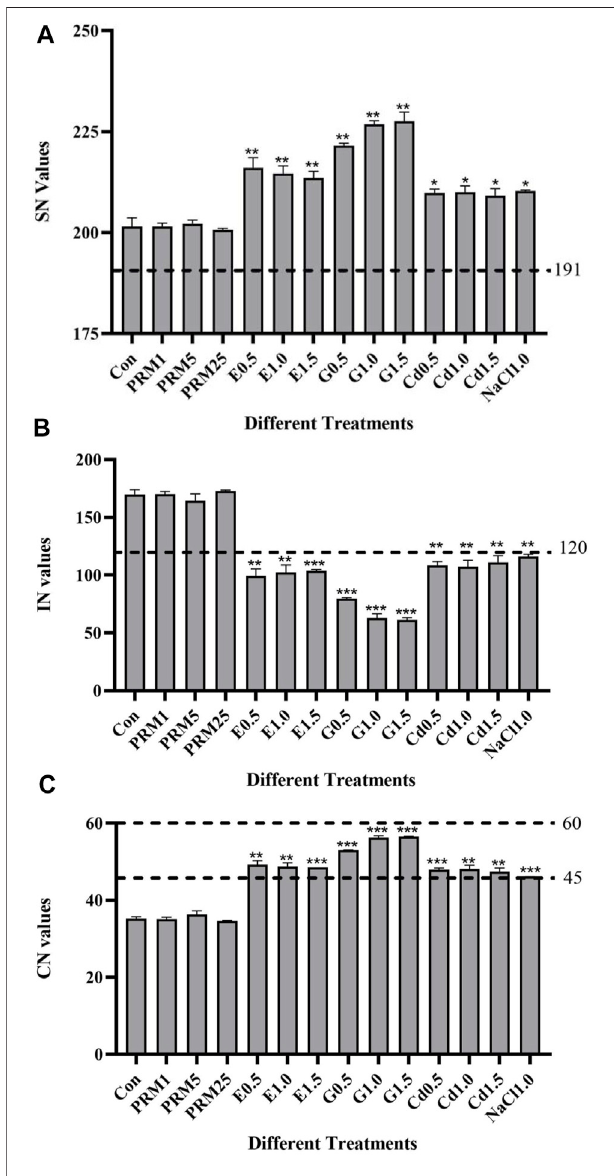
FIGURE 2 | Biodiesel fuel properties of E. gracilis TFA under different treatments at the sixth day. (A) saponi fi cation value (SN), (B) iodine value (IN), (C) cetane number (CN). Asterisks “ * ” , “ ** ” indicate signi fi cant differences between treatments and control treatment (Con) at p < 0.05 and p < 0.01, respectively. Lines indicate the standard threshold values for each biodiesel fuel property (SN, IN, or